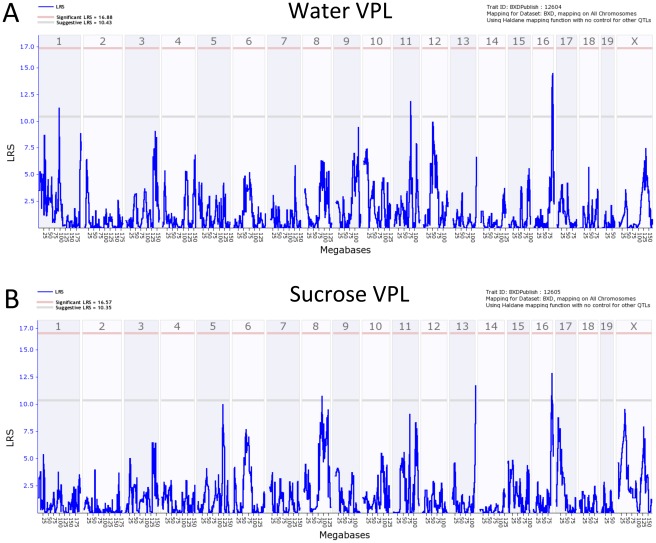
Genome-wide linkage QTL maps of VPL.A. Water VPL. B. Sucrose VPL. QTLs on chromosome 1,11 and 16 exceed the suggestive threshold (gray line; p<0.63) for water. QTLs on chromosome 8,13 and 16 exceed the suggestive threshold for sucrose.